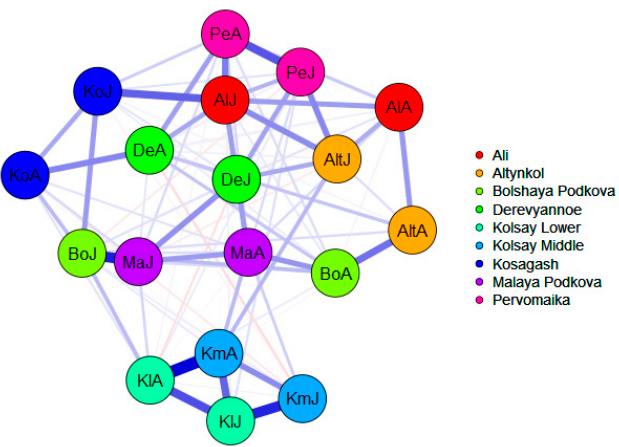
Figure 3. Phytoplankton species similarity assessment according to the JASP network plot. Ab-